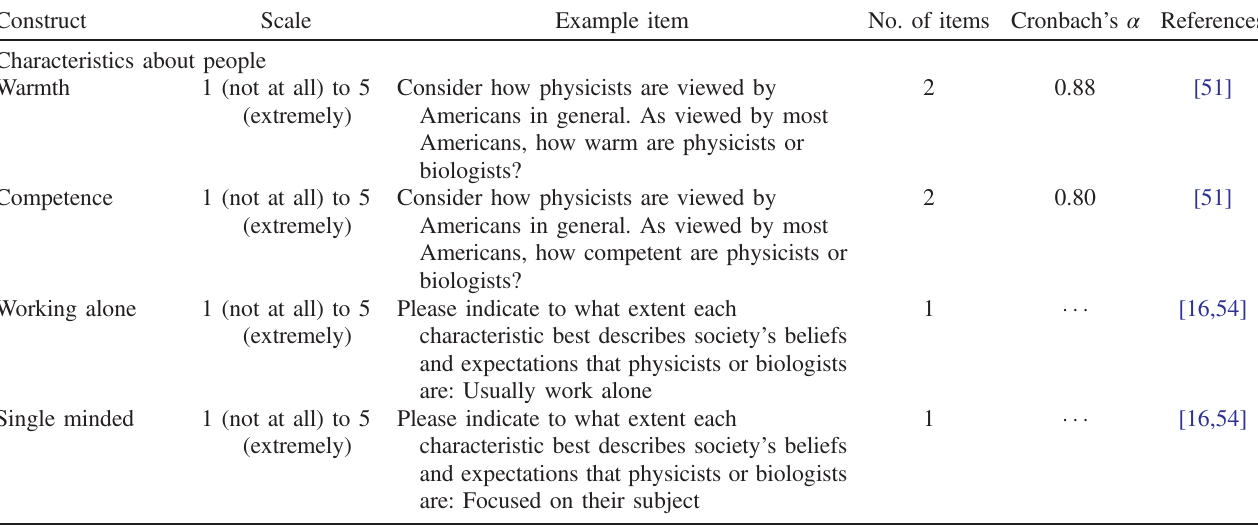
TABLE I. Measures used in the study.